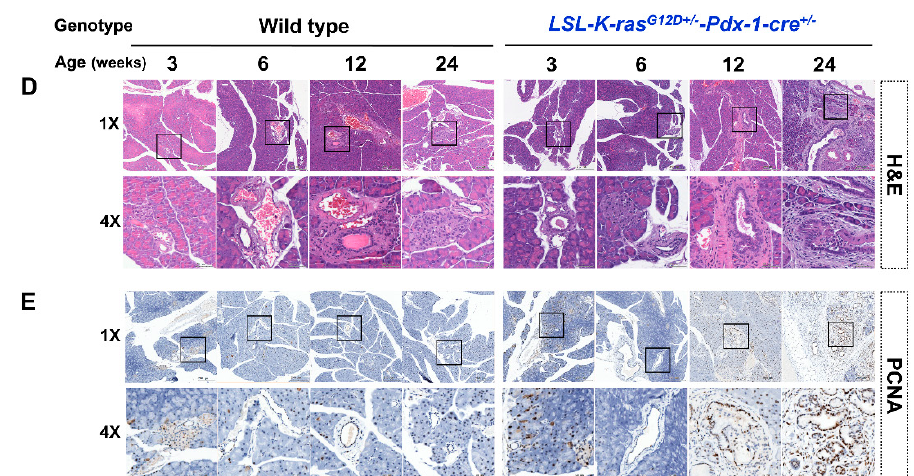
Figure 1. Accelerated pancreatic ductal adenocarcinoma (PDAC) progression in a transgenic LSL-K-ras G12D+/- - Pdx-1-cre +/- mouse model. ( A ) No significant difference was observed between the body weights of non-treated KC mice and non-treated wild-type mice at 3, 6, 12, and 24 weeks. ( B ) Comparison of pancreas size for KC mice with age- and sex-matched wild type mice at 24 weeks. ( C ) KC mice showed significantly increased pancreas weights ( p = 0.0023) at 24 weeks. ( D ) Representative H and E staining images of the mouse pancreas at 3, 6, 12, and 24 weeks. KC mice developed pancreatic intraepithelial neoplasia (PanIN) lesions at 6, 12, and 24 weeks (scale bar, 200 µm). ( E ) Representative images of proliferating cell nuclear antigen (PCNA) staining of the mouse pancreas, indicating a significant increase in cell proliferation at 12 weeks in KC mice (Figure 1E) (scale bar, 50 µm). WT, wild type; KC, LSL-K-ras G12D+/- - Pdx-1-cre +/- .